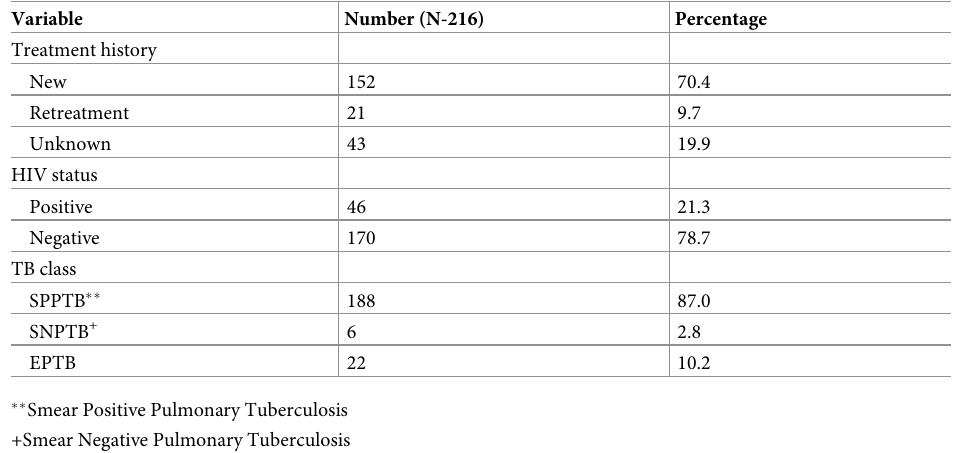
Table 2. Clinical characteristics of TB patients treated in five main prison settings in Bauchi State from January 2014 to December